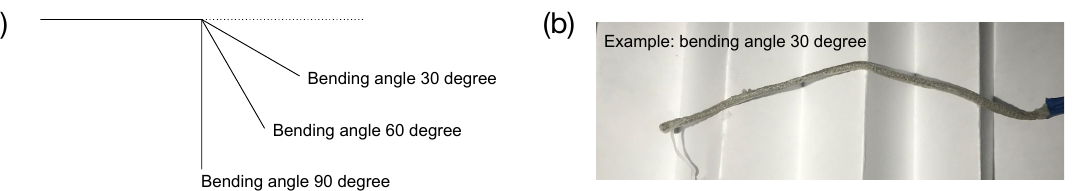
Figure 12. Sensor characterization with sharp static sensor bending: ( a ) the bending angle and its corresponding sensor position; and ( b ) a photo of the sensor with a bending angle of 30 ◦ during the experiment.